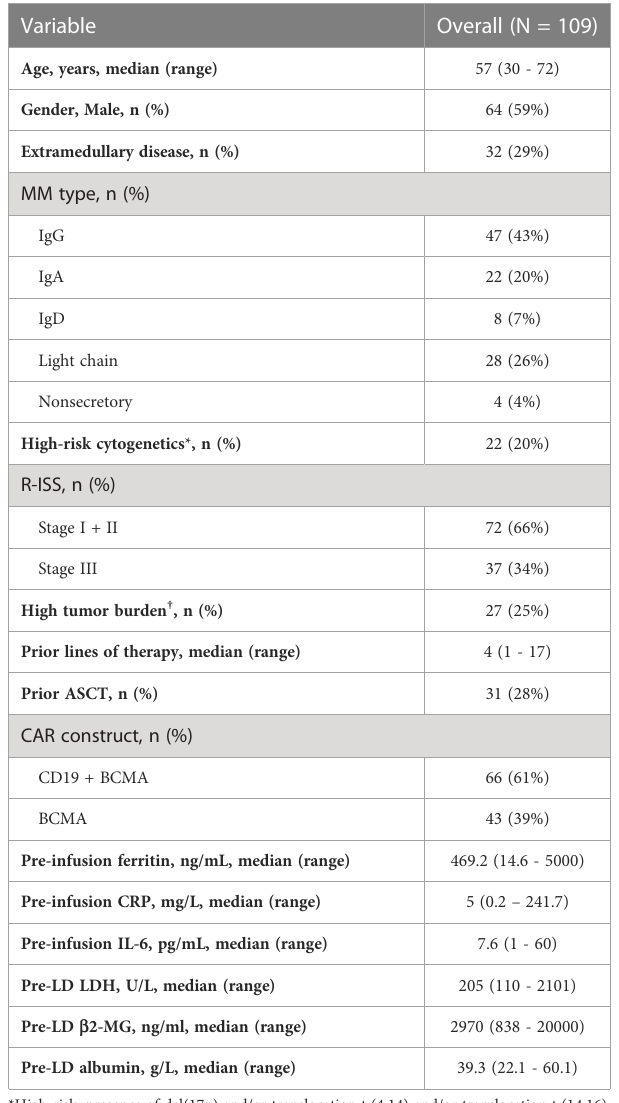
TABLE 1 Baseline characteristics of 109